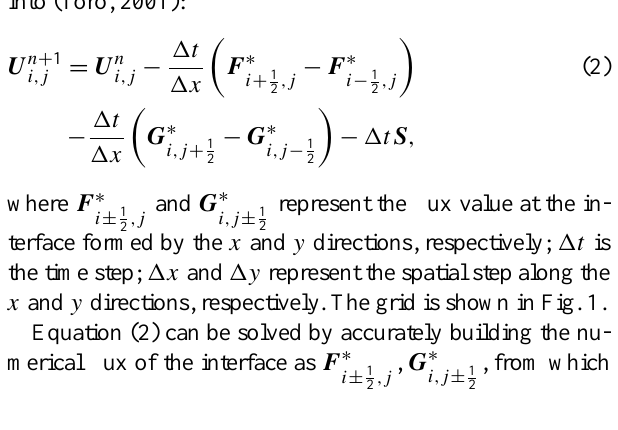
Fig. 2 Lateral widening mode of the break.